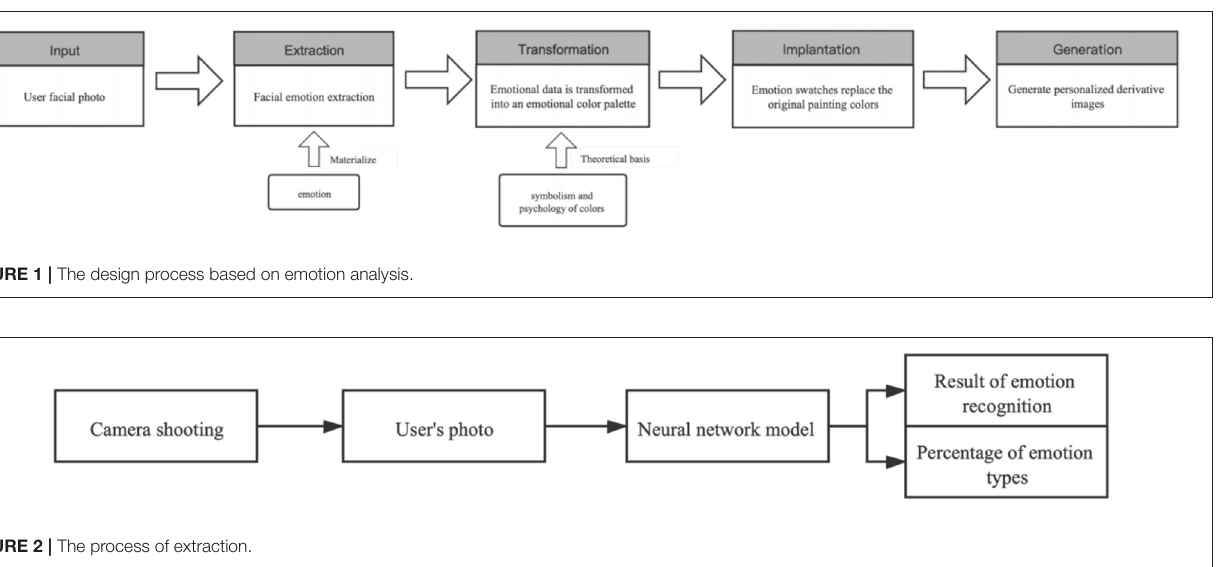
FIGURE 2 | The process of extraction.